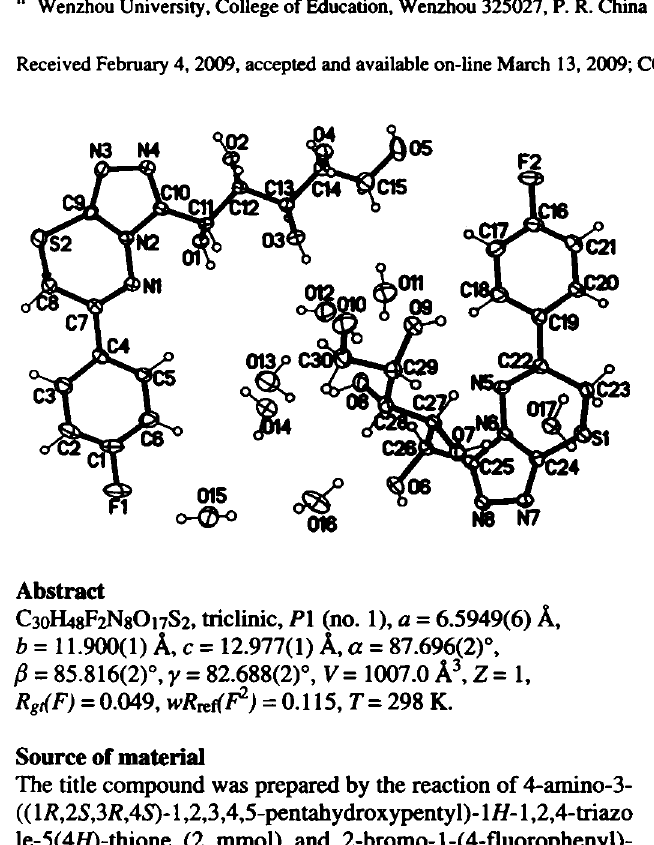
Table 2. Atomic coordinates and displacement parameters (in Â 2